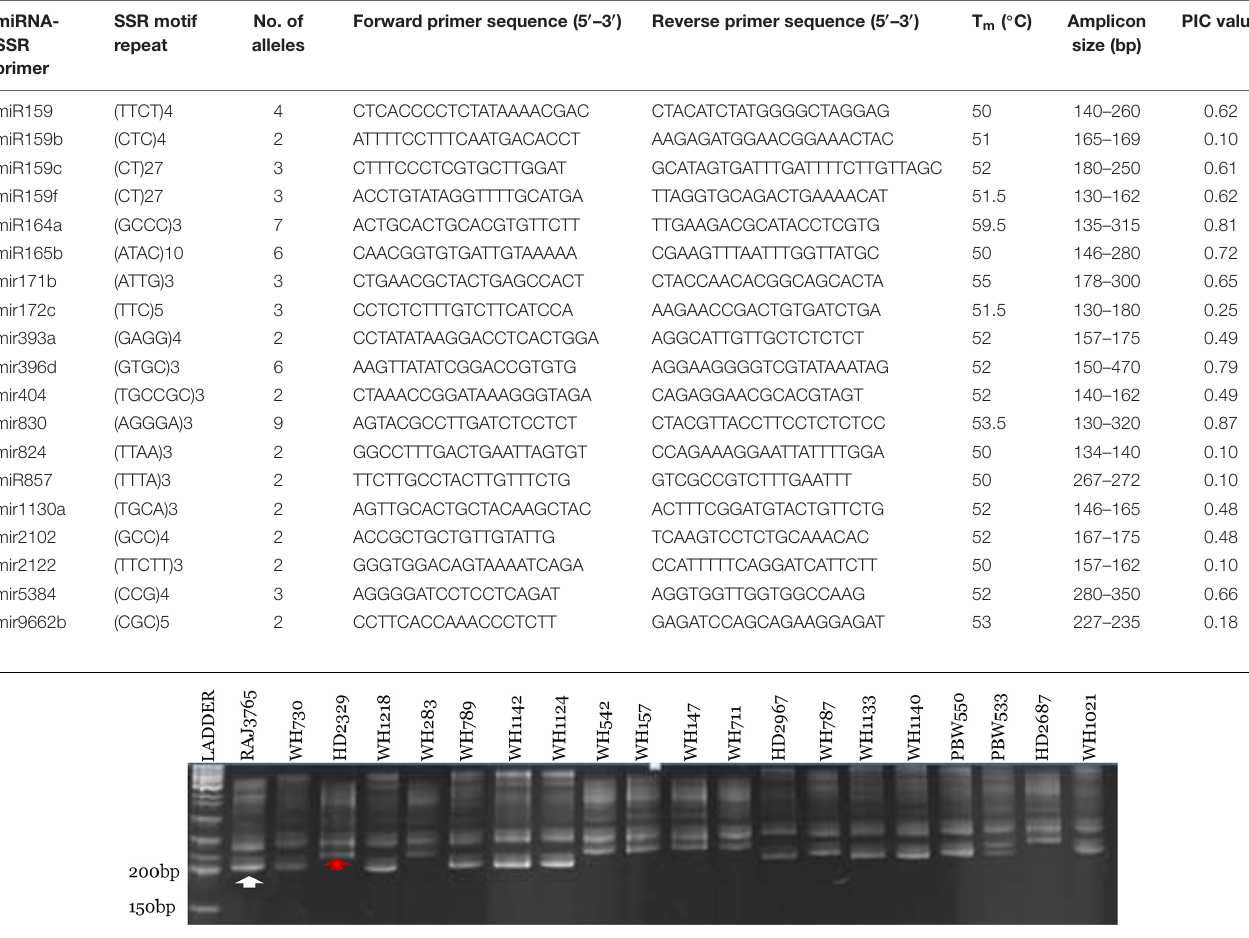
FIGURE 3 | Denaturing 10% urea-PAGE profile represents polymorphic pattern of miR159c miRNA-SSR marker over 20 terminal heat-tolerant/heat-susceptible wheat genotypes. First lane represents 50 bp DNA ladder, and the white and red arrow denote terminal heat-tolerant and heat-susceptible wheat genotypes, respectively.